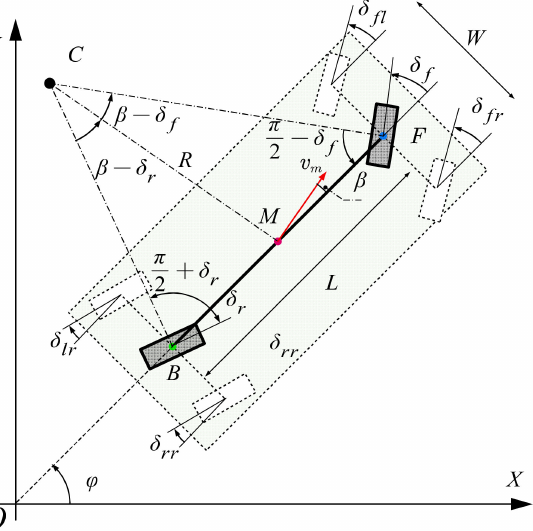
Figure 2. Schematic diagram of relevant variables of 4WS vehicle kinematics